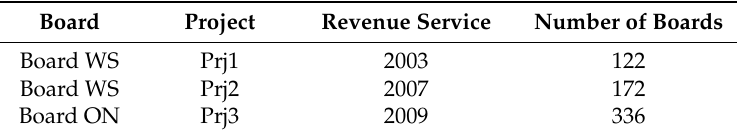
Table 1. Board and project information matrix.